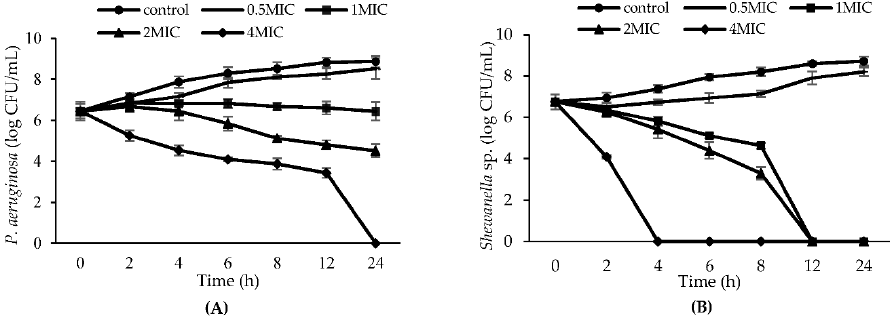
Figure 3. Time-kill curves of P. aeruginosa ( A ) and Shewanella sp. ( B ) without and with CLE treatment at different concentrations. Bars represent standard deviation ( n = 3). MIC: Minimum Inhibitory